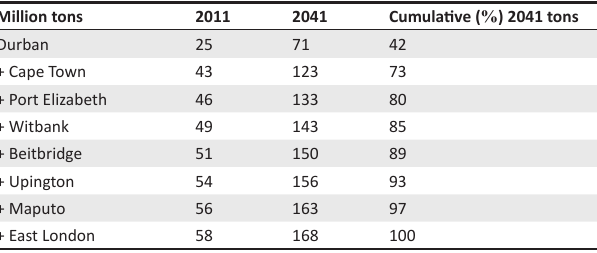
FIGURE 7: Corridor freight demand growth and relative size per packaging type (a) 2011 vs 2041 and (b) 2011 only. TABLE 2: Cumulative intermodal facilities with Gauteng as intermodal